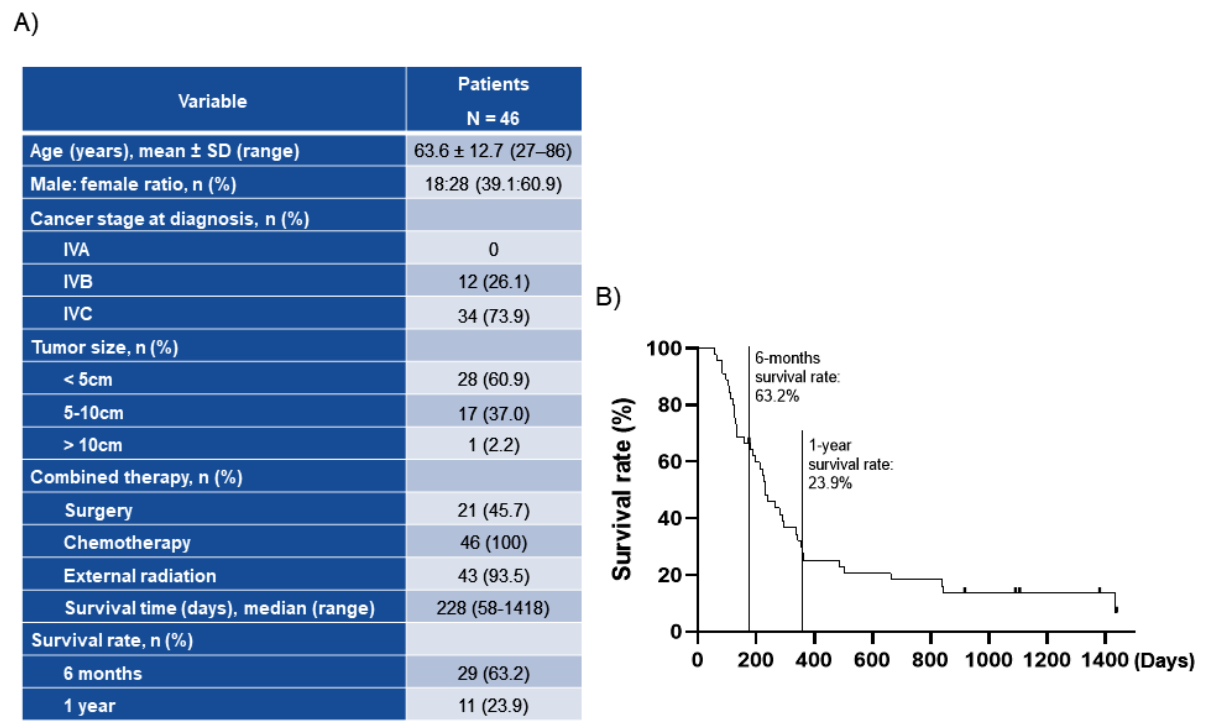
Figure 1. Information of ATC patients: ( A ) Patient characteristics and clinical features; ( B ) Survival rates of patients with anaplastic thyroid cancer. The cancer stage was determined according to the 8th edition of the AJCC/UICC by the American Joint Committee on Cancer and the International Union Against Cancer.